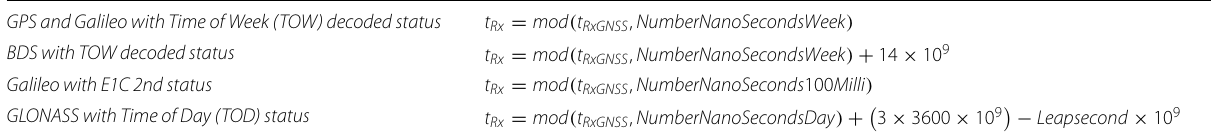
Table 3 Summary of t Rx [ns] computation GPS and Galileo with Time of Week (TOW) decoded status t Rx = mod ( t RxGNSS , NumberNanoSecondsWeek ) BDS with TOW decoded status Galileo with E1C 2nd status GLONASS with Time of Day (TOD)